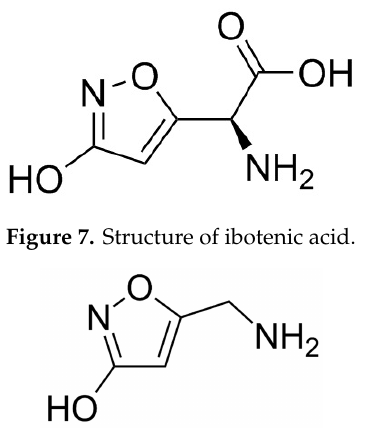
Figure 8. Structure of muscimol.